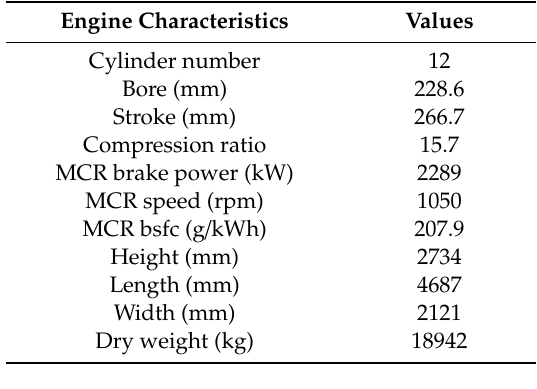
Table 1. General Electric (GE) marine 12V 228 four stroke diesel engine main data. MCR = maximum continuous rating; bsfc = brake specific fuel consumption.